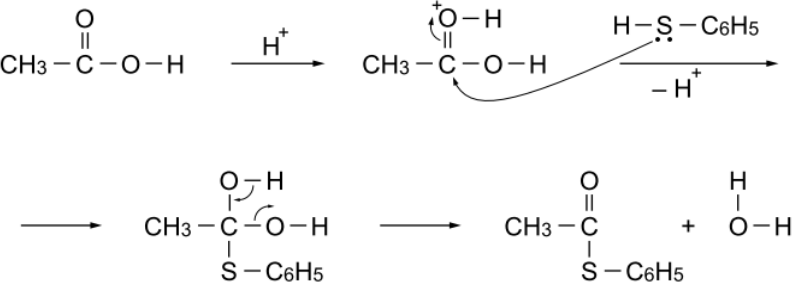
a After activation of catalyst (30.0 mg) in hydrogen stream (300 mL/h) at 300 °C for 1 h, reaction was started by introduction of benzenethiol (102 μL/h, 1.0 mmol/h) and acetic acid (114 μL/h, 2.0 mmol/h) to the stream without changing the temperature. At 3 h after the start of the reaction; b Reference catalyst, The Catalysis Society of Japan; c Crushed and screened (166–200 mesh) crystals (Nippon Inorganic Colour and Chemical Co., Ltd., Tokyo,